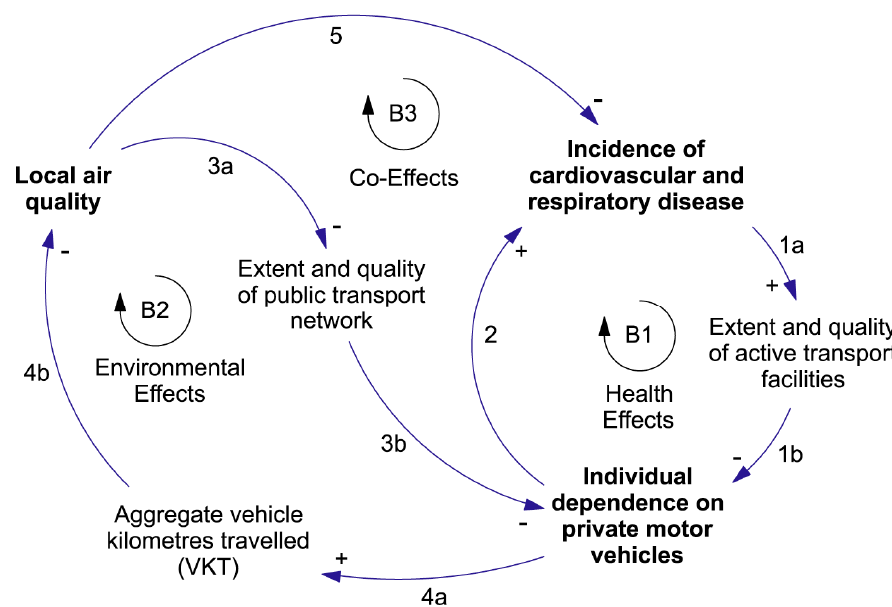
Figure 6. A causal loop diagram concerning selected co-effects of vehicle-dependence in urban settings. The arrows represent causal links and are labelled in accordance with the numbering scheme used in the Co-Effects Template. Each arrow has been assigned a polarity. The state-change processes represented by each arrow are described in Table 5. Links 1, 3 and 4 each have two components, labelled “a” and “b”. The encircled symbols B1, B2 and B3 indicate that all three feedback loops are